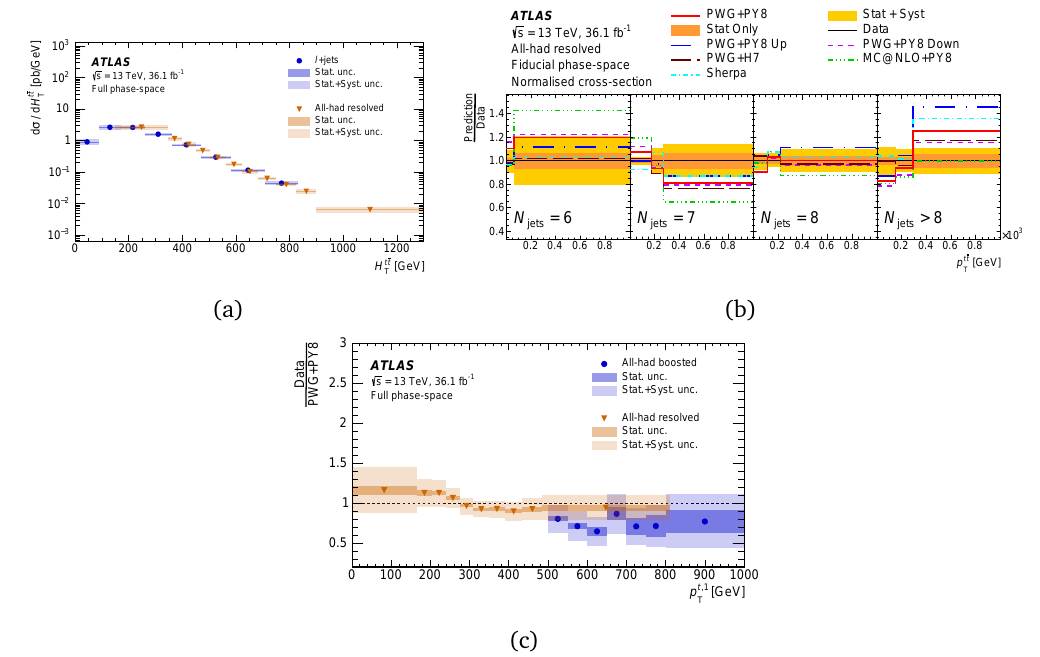
Figure 2: a: Comparison between the measured differential cross-sections at parton- level, in the (cid:96) + jets and all-hadronic channels, as a function of the scalar sum of the top-quarks p ( H tt ). b: Double-differential normalised cross-section at particle-level, T T as a function of the tt pair transverse momentum in bins of the jet multiplicity. c: Ra- tio of the measured parton-level differential cross-sections to Monte Carlo predictions in the all-hadronic resolved and boosted topologies. From [ 4 ]